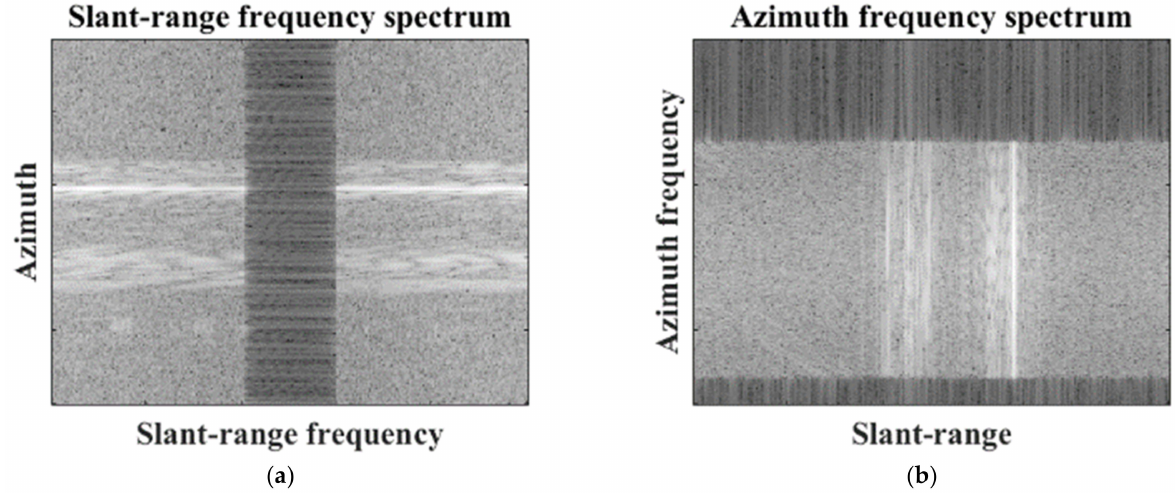
Figure 3. Frequency spectrum of target image. ( a ) Slant-range frequency spectrum, ( b ) azimuth frequency